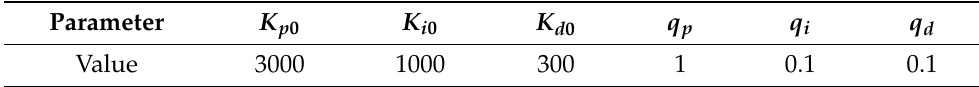
Table 5. Adaptive fuzzy PID controller setting